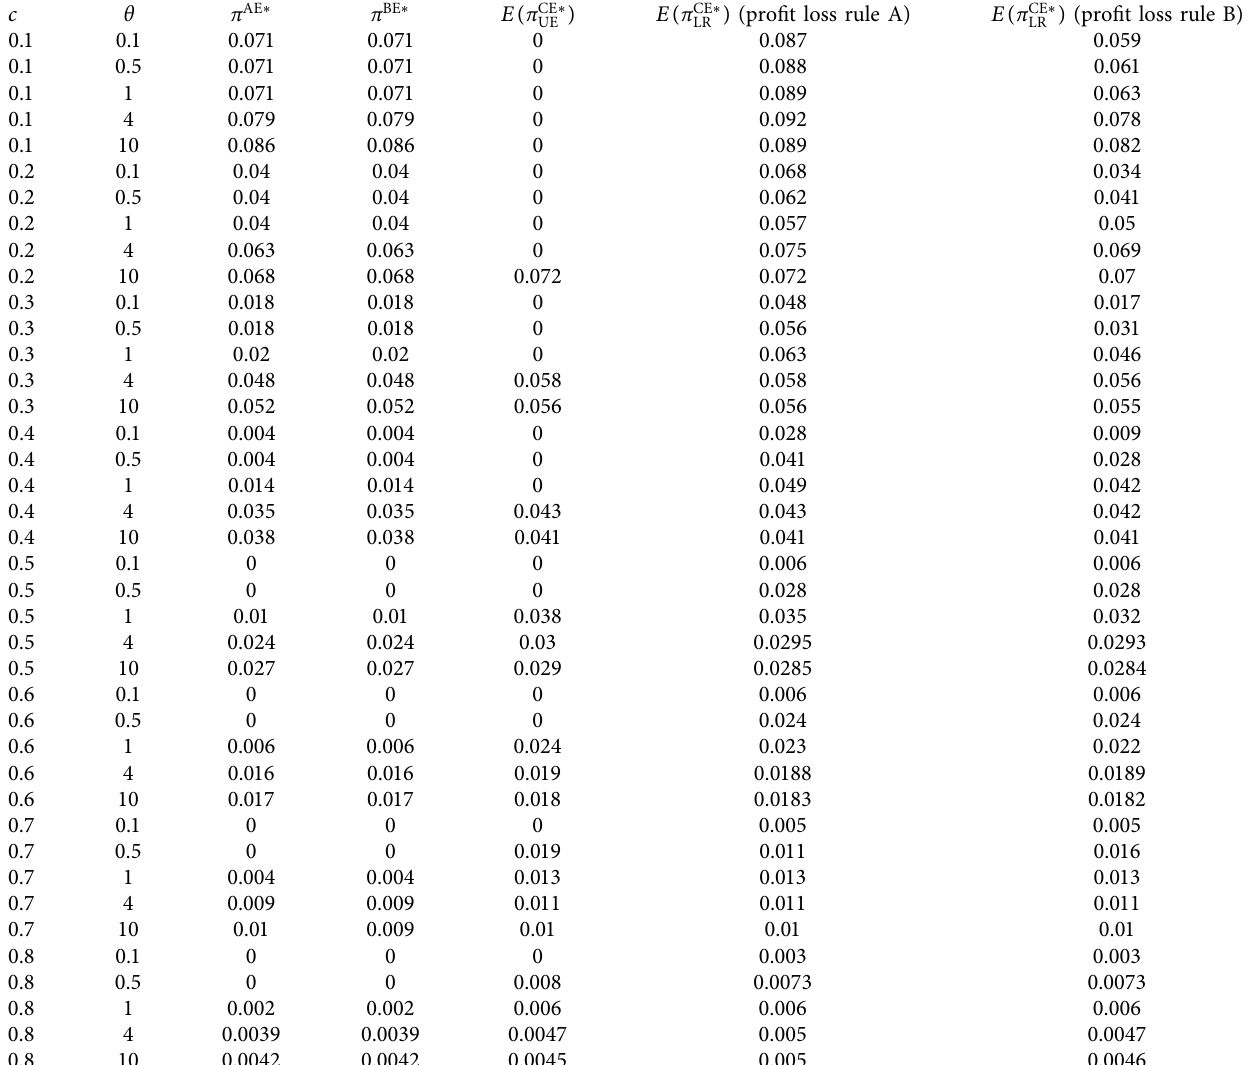
Table 4: Numerical examples of Firm E’s profit in different